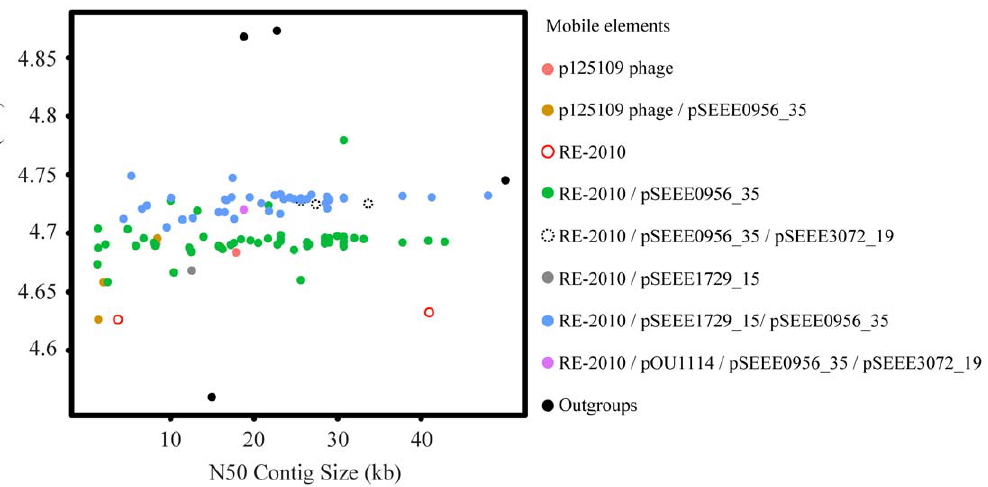
Figure 1. The number of assembled bases and N50 contig size listed for each of the sequenced isolates. Points are colored according to the phages and plasmids that were found in the sequencing results.